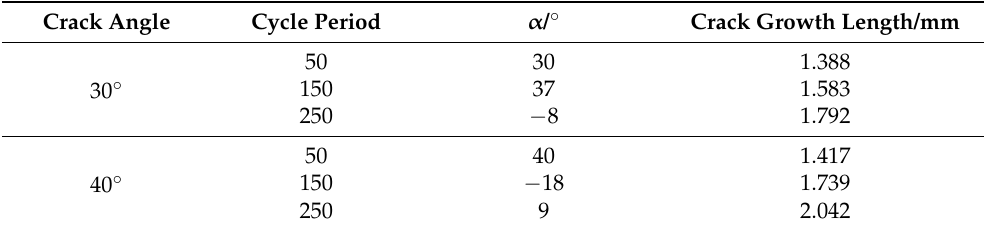
Table 3. The step-by-step loading fatigue expansion